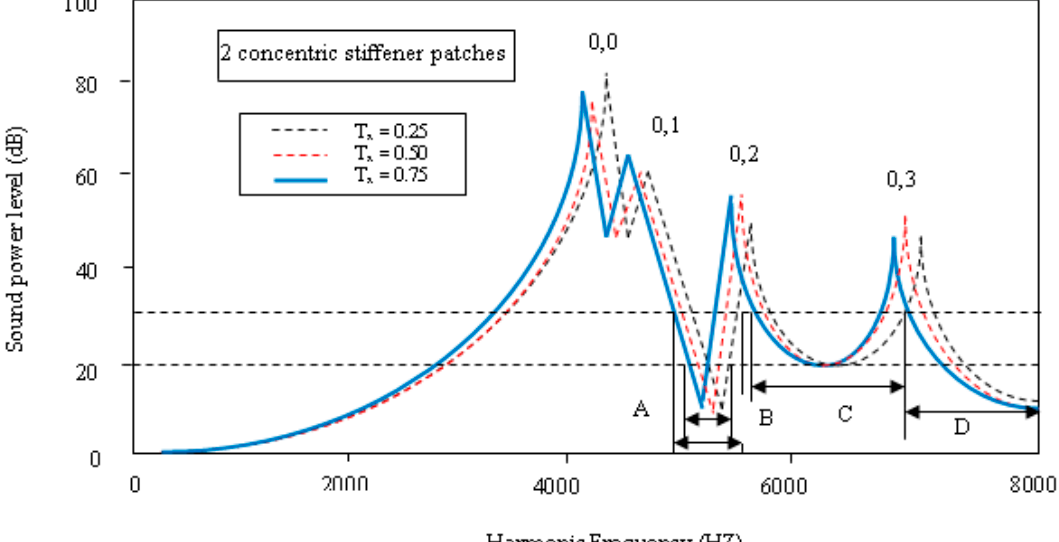
Figure 14. Numerical comparison of sound power level for annular plate attached with 2 concentric stiffener patches and having parabolic decreasing thickness variations (Case I) for different taper ratios T x .